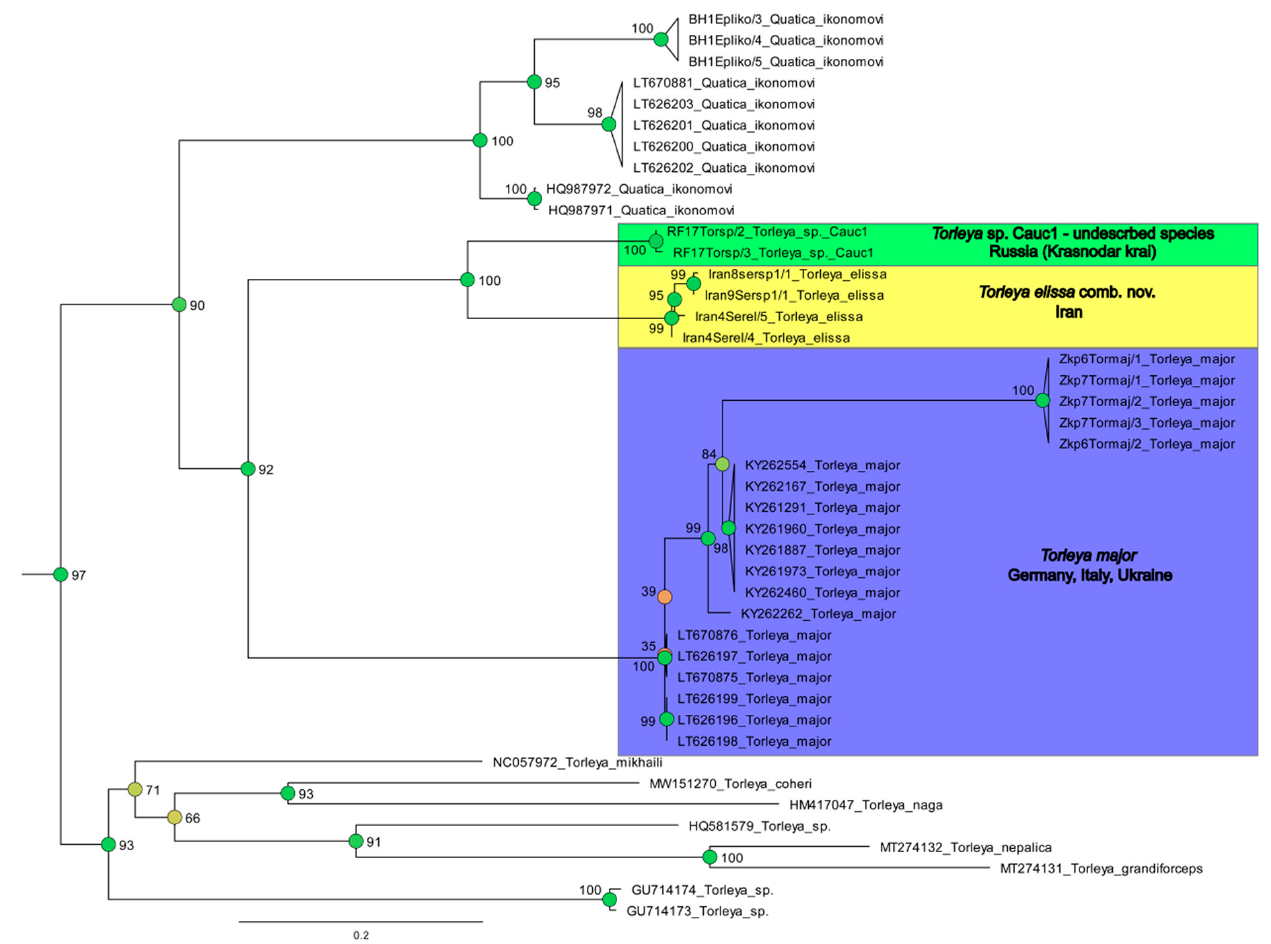
Figure 13. Part of Maximum likelihood tree on tribe Hyrtanellini showing lineage with Torleya Lestage, 1917 and Quatica Jacobus & McCafferty, 2008. Branches provided with Bootstrap supports (BS). Support values are colored based on confidence at internal nodes; from yellow (low) to green (high). Green, yellow and purple backgrounds mark different species.